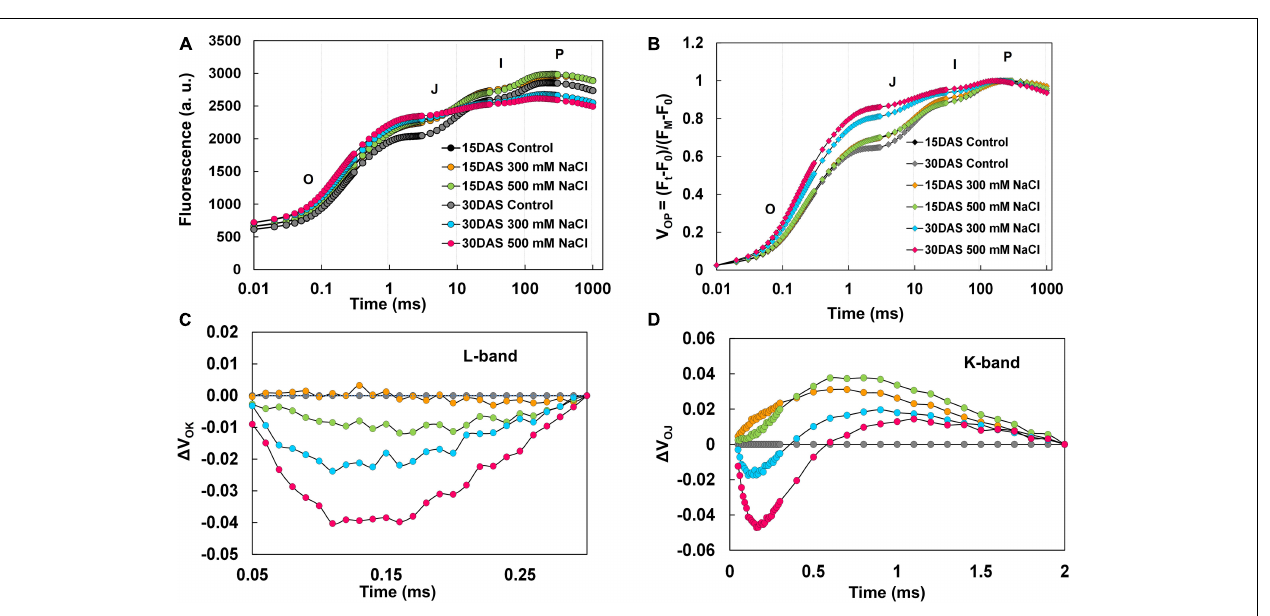
FIGURE 5 | Polyphasic chlorophyll a transients for O-K, O-J, O-I, and I-P phases in leaves of P. pinnata under salt-treated conditions. (A) Raw Chl a fluorescence transient curves observed florescence intensity recorded between 0.1 and 1,000 ms time period; (B) double-normalized Chl a fluorescence transients recorded between extreme O (Fo) and P (F M ) phases [V OP = (F t – Fo)/(F M – Fo)]; (C) kinetic difference between control and treated values of (cid:49) V OK (L-band) with respective controls represented by black and gray circles; (D) kinetic difference between control and treated values of (cid:49) V OJ (K-band) with respective controls represented by black and gray circles; data are mean ± SD ( n =